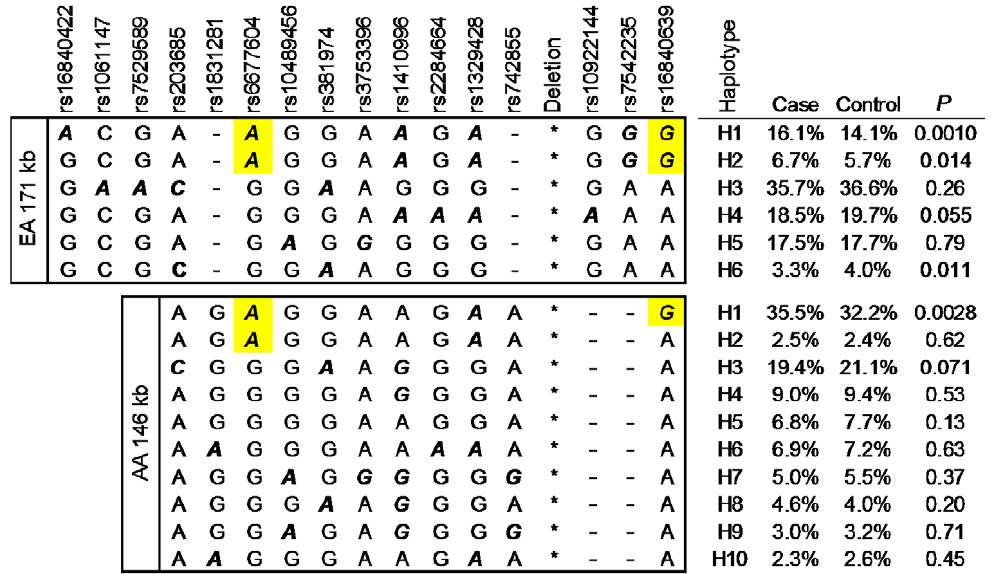
Figure 2. The minor allele of rs6677604 and rs16846039 tag risk haplotypes of SLE. Haplotypes containing rs6677604 and rs16846039 (frequency . 1%) are constructed in both EA and AA subjects, which correspond to the 2 nd and the 4 th block of EA and AA shown in Figure 1, respectively. SNPs not used to construct haplotypes are marked as ‘‘-’’. The minor alleles of rs6677604 and rs16840639 are highlighted in a yellow box. The minor allele of each SNP is bolded and italicized. The position of CFHR3-1 D is indicated as ‘‘*’’.